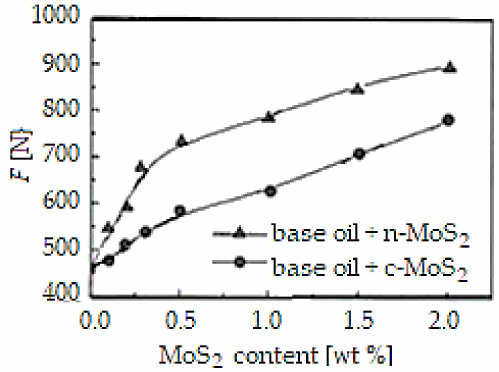
Figure 2. Variation of extreme load depending on the MoS 2 particle’s content via the four-ball tribometer (n-MoS 2 = MoS 2 nanoparticles; c-MoS 2 = common MoS 2 particles).